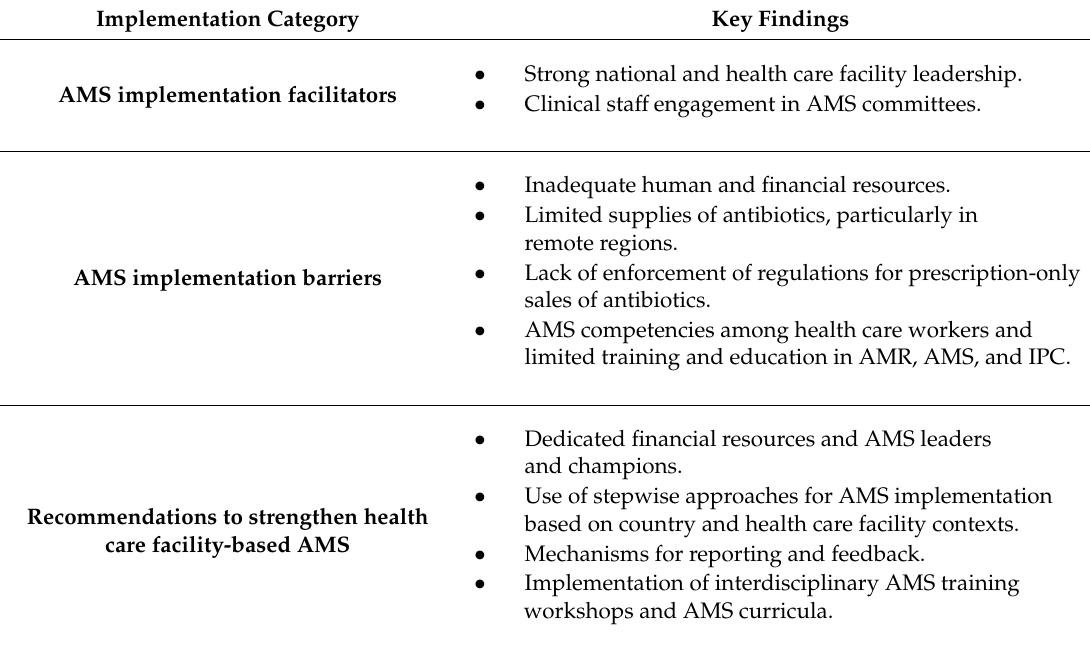
Table 3. Key findings for Implementation of AMS in